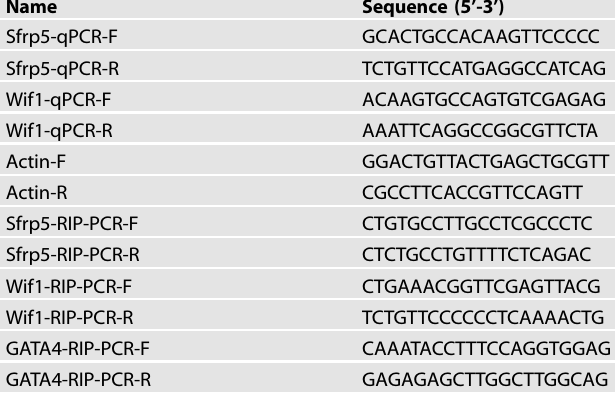
Fig. 5 CUGBP1 directly binds to the RNA of Wif1 and Sfrp5. A RIP analysis was carried out using antibodies against CUGBP1 in NRVMs and RT-PCR assay was performed using primers targeting Wif1, Sfrp5, or GATA4, respectively. B Proposed mechanism of CUGBP1-Wnt/ β -catenin- GATA4 regulatory axis. CUGBP1 abundance is upregulated upon apical resection. Therefore, altered levels of CUGBP1 interfere and downregulate the Sfrp5 and Wif1, which leads to activation of Wnt/ β -catenin signaling. Consequently, cardiomyocyte proliferation and GATA4 levels is elevated, which could contribute to heart regeneration. Table 1. List of primers used in this